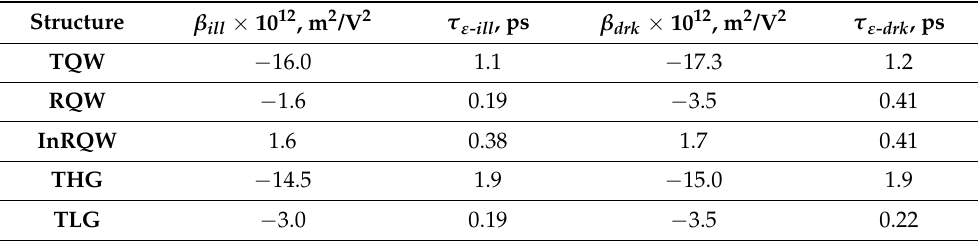
Table 4. Electron energy relaxation time τ ε -ill and τ ε -drk under illumination and in the dark, respec- tively, evaluated from corresponding I-V characteristic’s nonlinearity coefficients β ill and β drk of different asymmetrically necked semiconductor structures (model of Equation